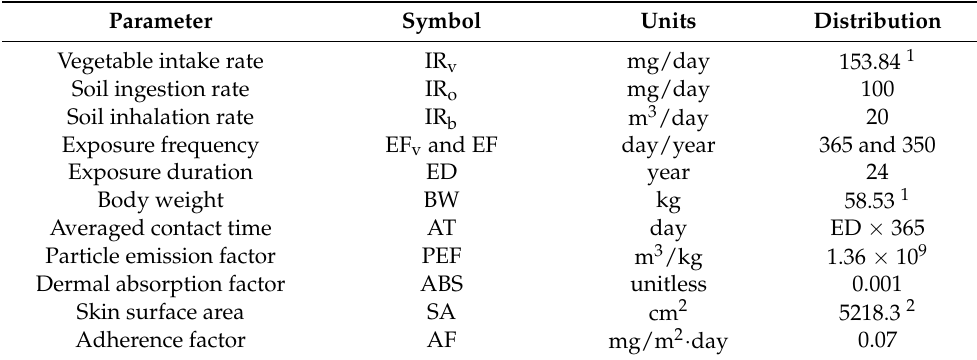
Table 1. Parameters and their values used to evaluate physical